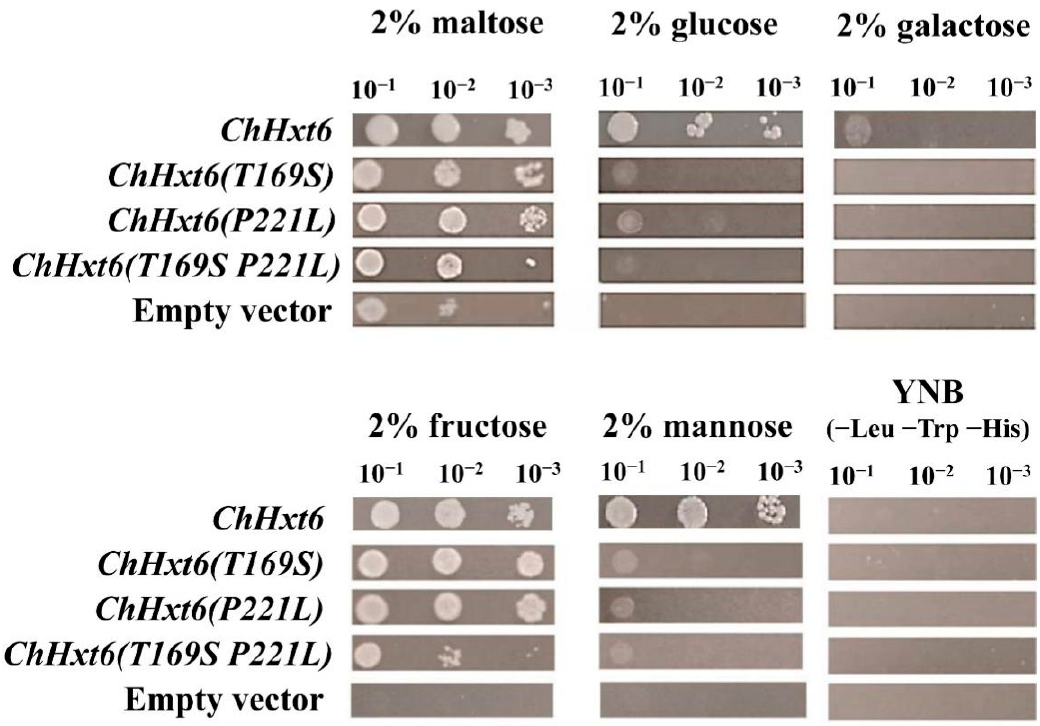
Figure 7. Growth of the Saccharomyces cerevisiae strains EBY.VW4000 and EBY.VW4000 expressing ChHxt6 site-mutation variants with amino acid exchanges on media containing different monosaccharides. Growth was observed after incubation at 28 °C for three days.